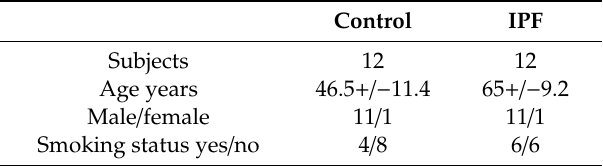
Table 1. Baseline characteristics of non-IPF control and patients with